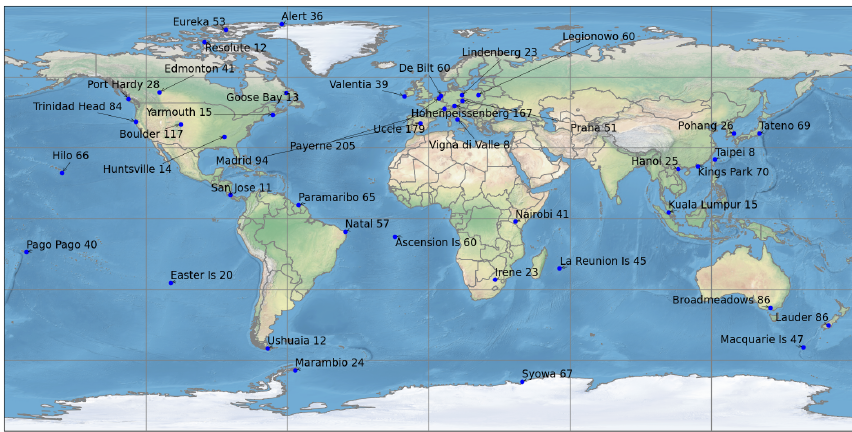
Figure 3. Global distribution of the ozone sounding stations. The number of soundings used in this study is given next to the station’s name. Image made using Natural Earth free vector and raster map data from https://www.naturalearthdata.com/ (last access: January